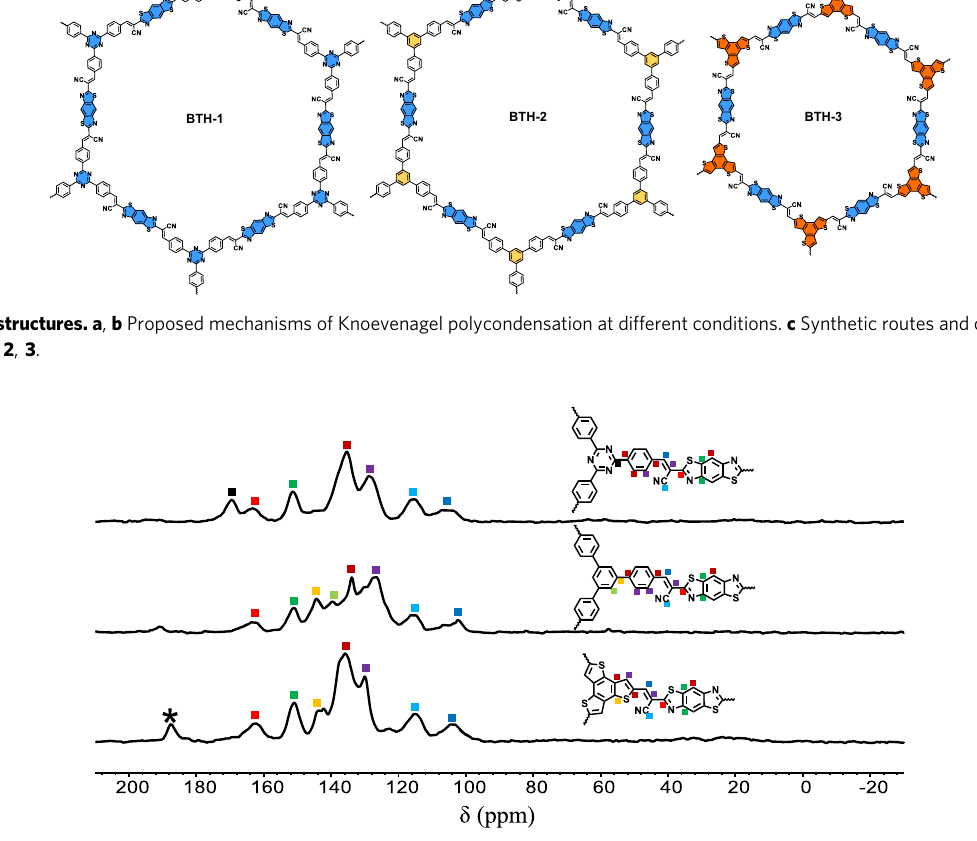
Fig. 2 Solid-state 13 C CP-MAS NMR spectra of BTH-1, 2, 3. * signal of residual aldehyde